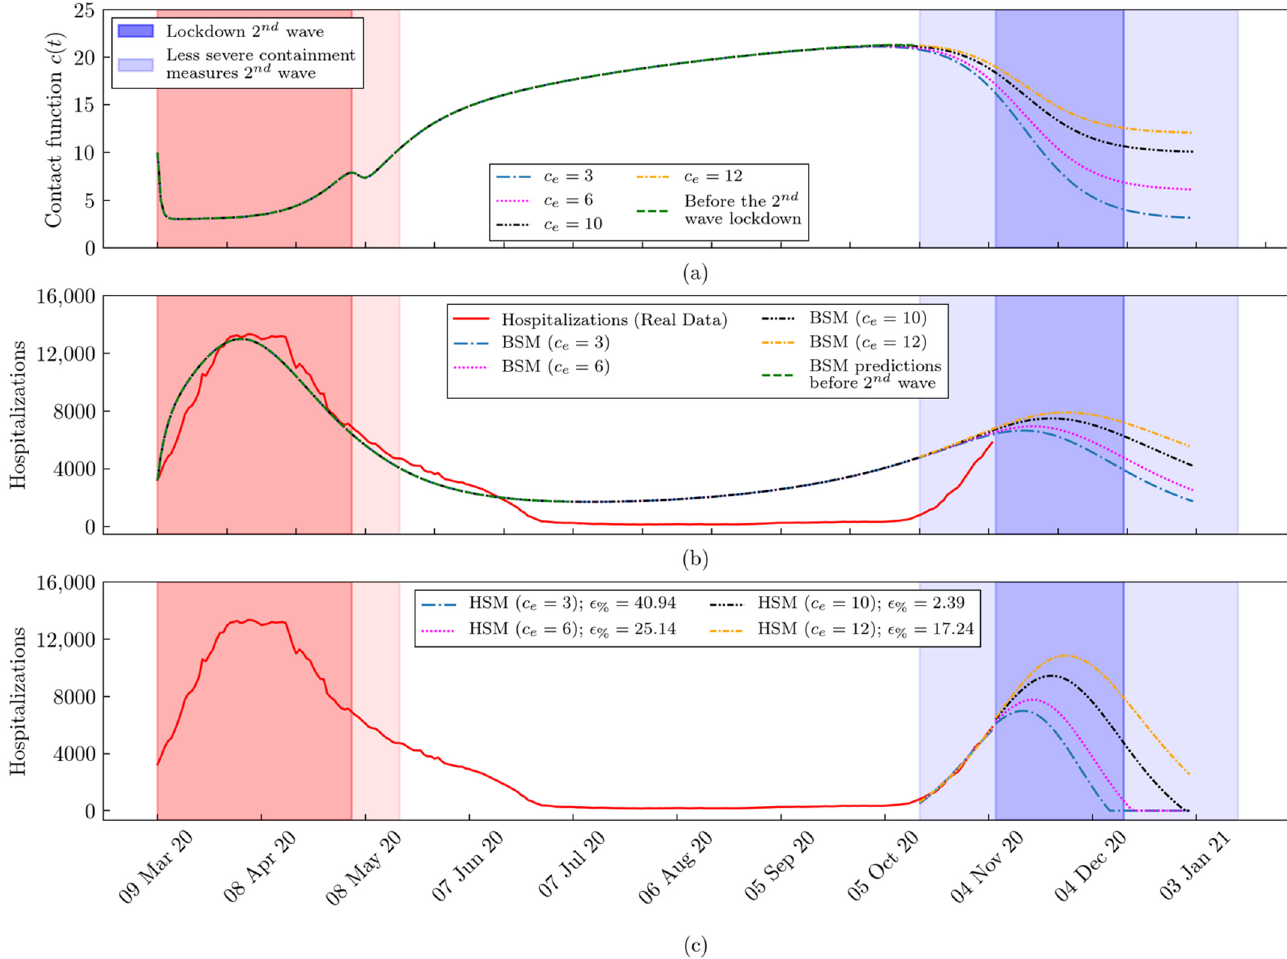
Figure 5. COVID-19 hospitalization estimates in Lombardy according to different scenarios of personal contacts. HSM hospitalizations predictions assuming different scenarios of personal contacts during the second wave lockdown. The supposed contacts trend is shown in panel ( a ), whereas panel ( b , c ) show the different hospitalization scenarios using BSM and HSM, respectively. For each scenario, the average percentage error ( 𝜖 % ) from 6 November to 8 December 2020 is also reported.